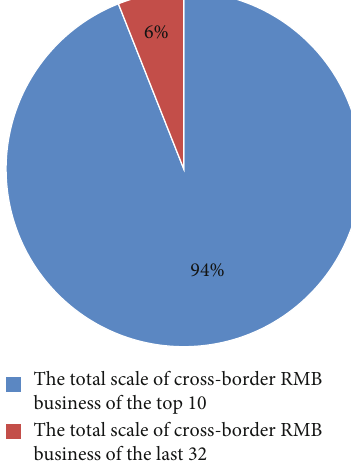
Figure 1: The total scale of cross-border RMB